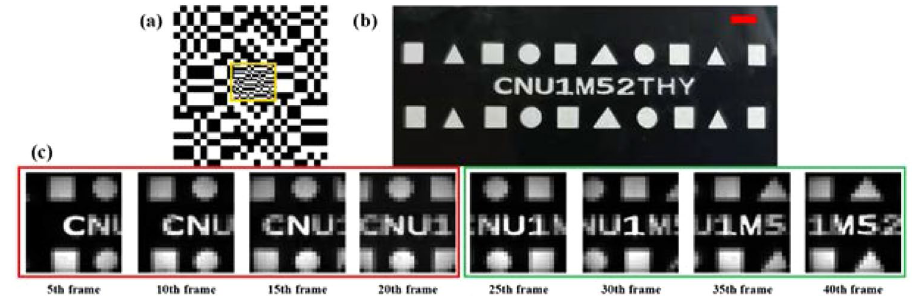
Figure 5. Experimental results of a single-pixel video with a static ROI. ( a ) Light patterns for the ROI (the yellow border selected area). ( b ) Object and scale bar in red = 4 mm. ( c ) Every fifth frame of the video (see Supplementary Video 1 for the complete video).